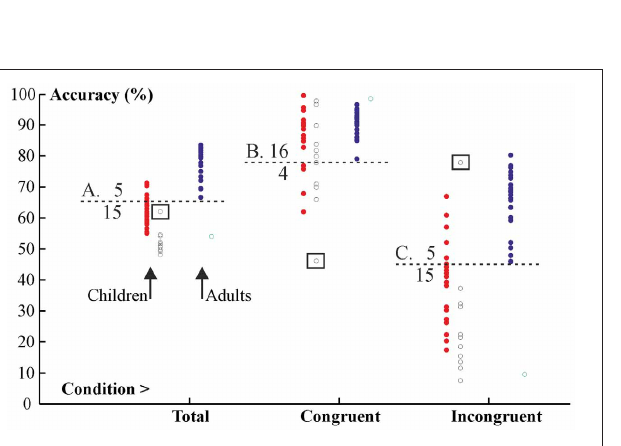
FIGURE 4 | Illustration of a Group × Congruency × Ratio ANOVA on accuracy (A,B) and reaction time (C,D) data. Ninety-five percentage confidence intervals are represented.